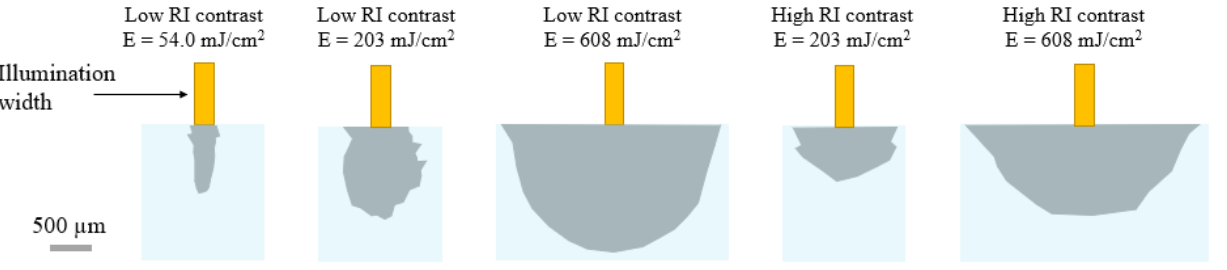
Figure 7. Effect of energy dose (E) on geometry of polymerized area. Adapted from